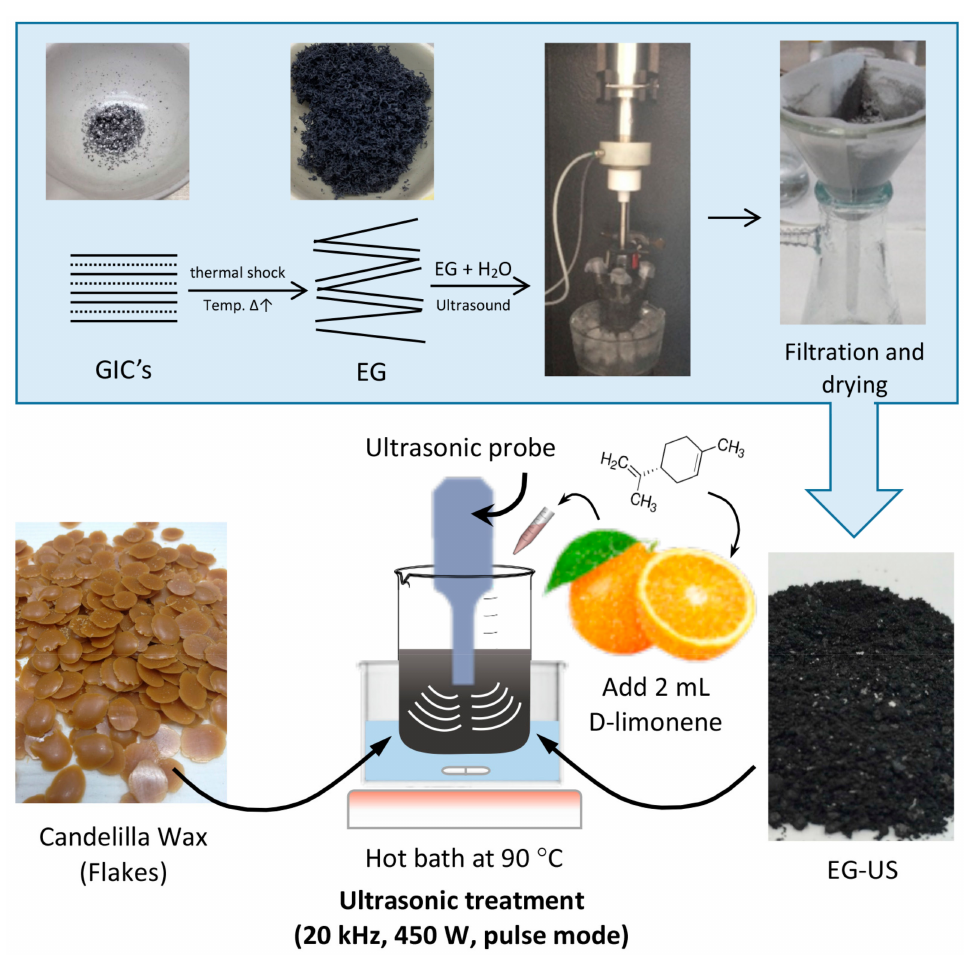
Figure 2. Scheme of the preparation of expanded graphite (EG)–wax nanocomposites. GIC, graphite intercalate